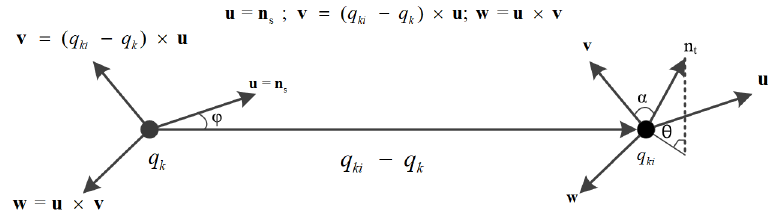
Figure 6. Diagram of local coordinate system